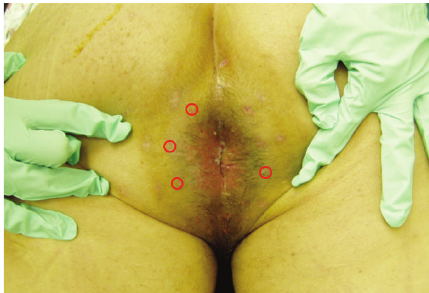
Figure 1: Mapping biopsies were taken circumferentially; four biop- sies were positive for Paget’s disease at the positions distinguished by red circles.